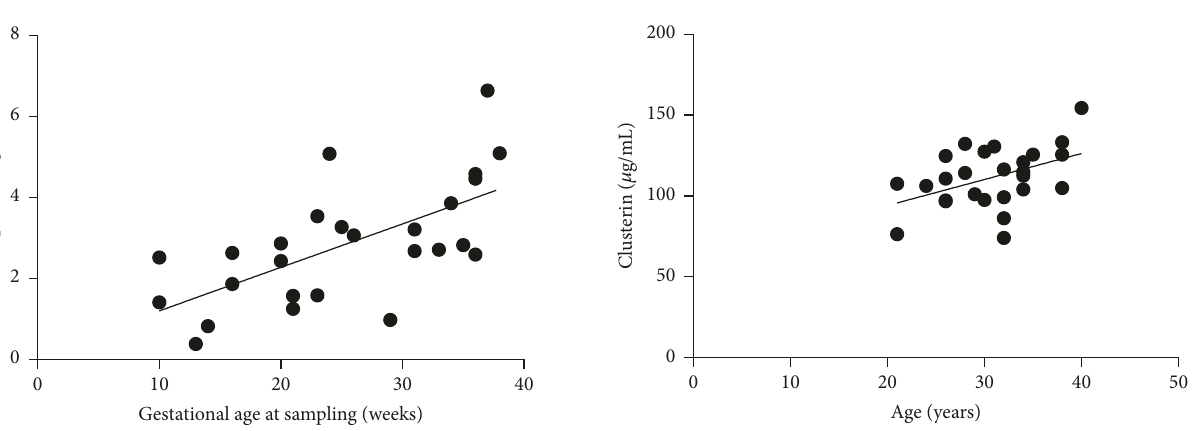
Figure 4: Positive correlation of subjects’ age to circulating clusterin levels in asthmatic pregnant patients. 𝑝 = 0.0442 ; 𝑟 = 0.3978